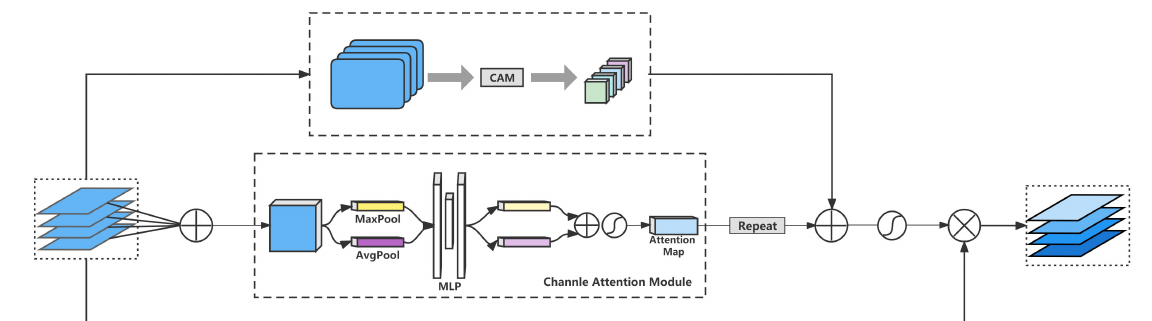
Figure 6. The diagram of the Intra- and Inter-class Channel Attention